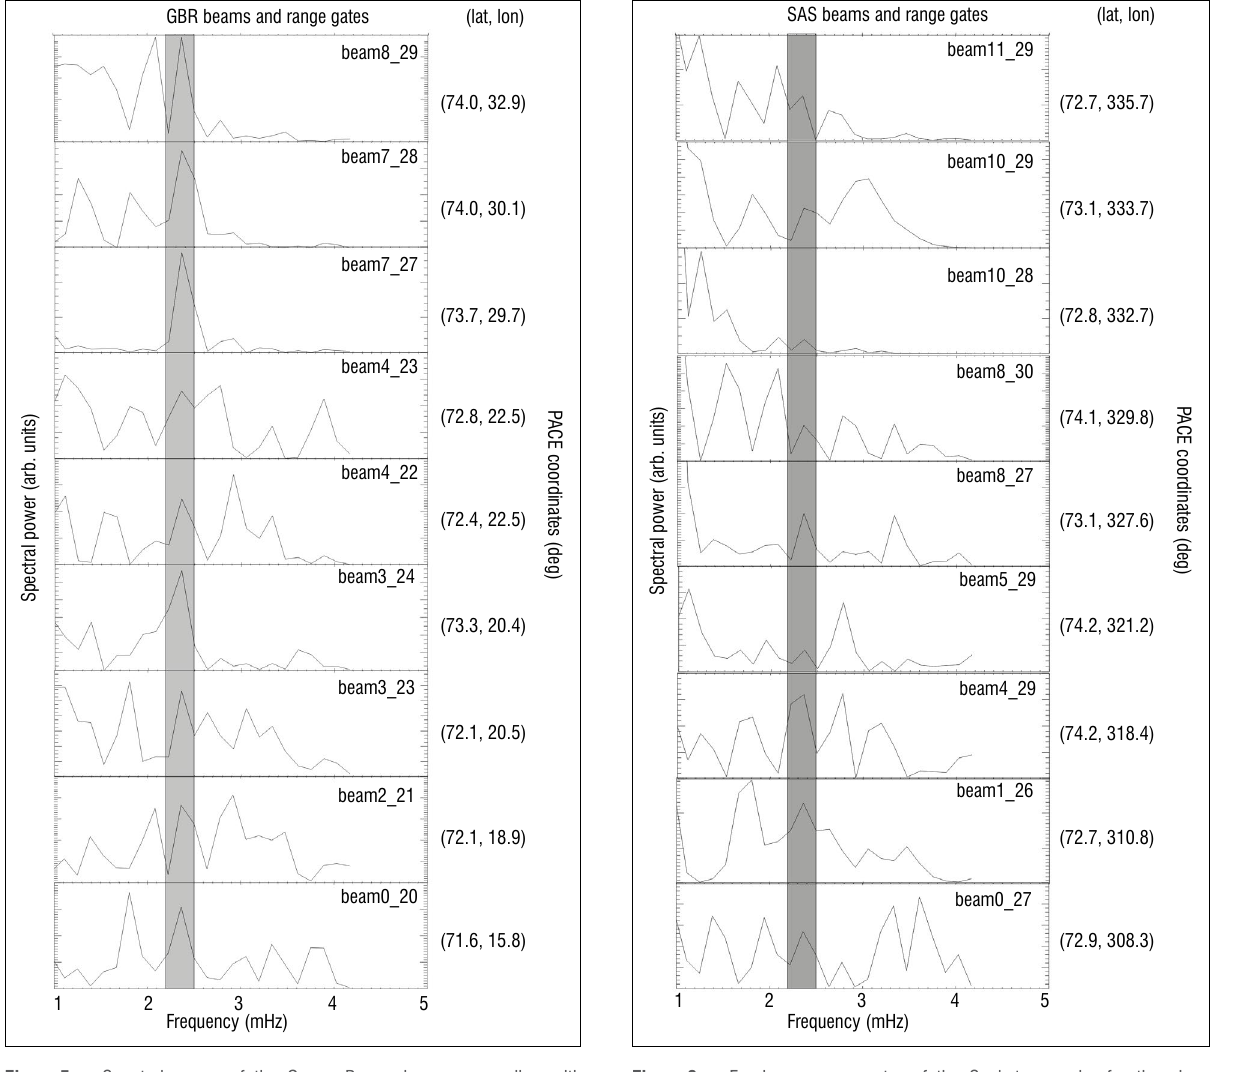
Figure 6: Fourier power spectra of the Saskatoon radar for the given beams and range